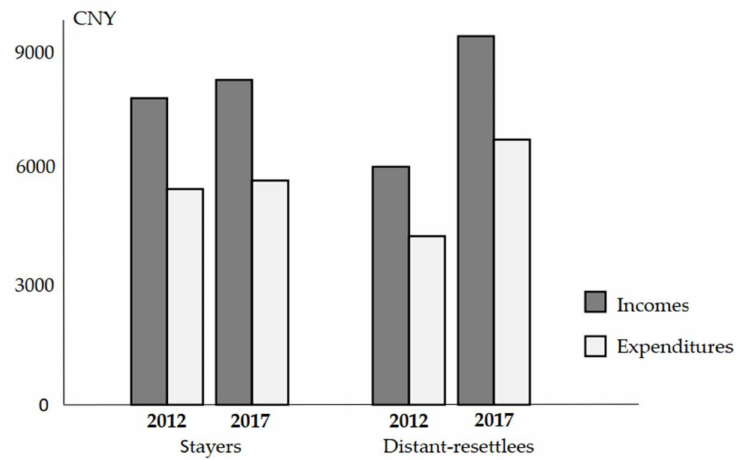
Figure 2. Per capita gross annual income and